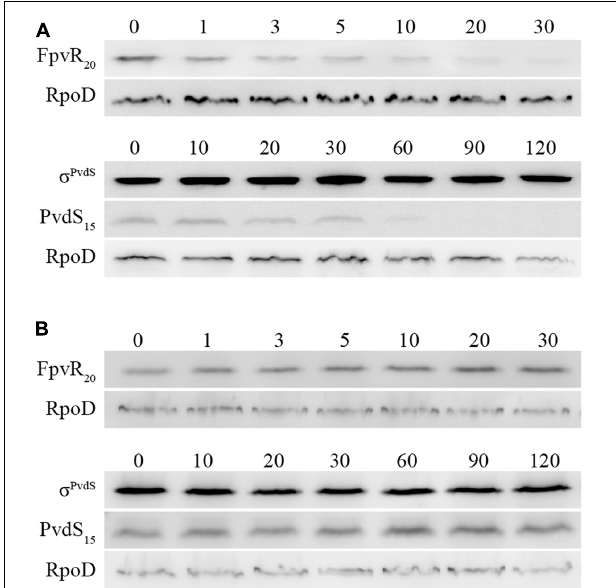
FIGURE 3 | Time-course of degradation of FpvR 20 and σ PvdS following addition of pyoverdine. Pyoverdine was added to P. aeruginosa bacteria (0 min). Samples were collected at intervals and analyzed by Western blotting with antibodies against FpvR 20 , σ PvdS or RpoD (loading control). FpvR 20 , σ PvdS (full-size), PvdS 15 and RpoD are indicated. Times are shown in minutes. (A) PAO1 pvdF (B) PAO1 pvdF fpvA . Similar results were obtained when the experiment was repeated (Supplementary Figure S2).